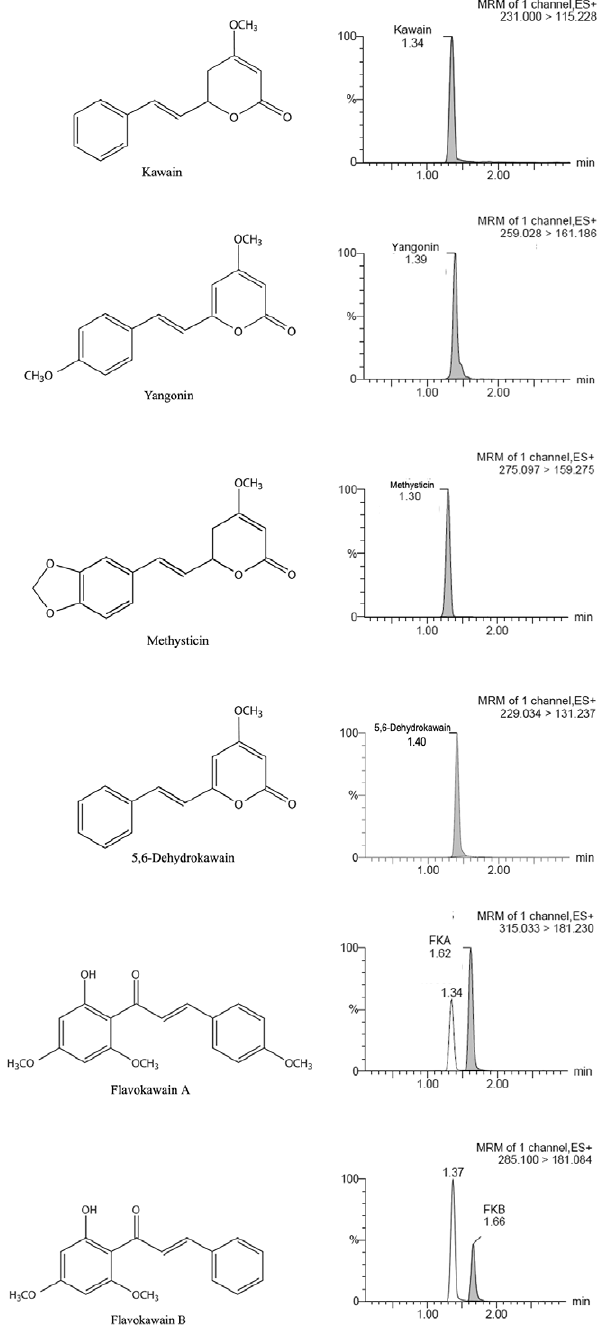
Figure 1. UPLC analysis of kavalactones and flavokawain B in the kava root